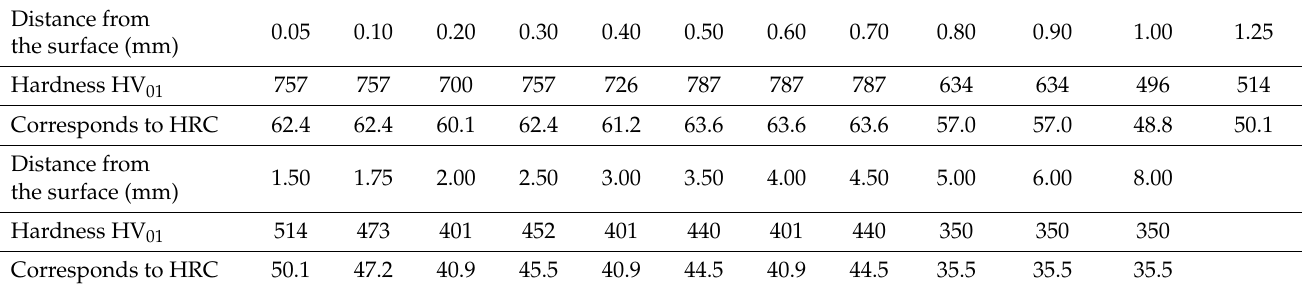
Distance from the surface (mm) Corresponds to HRC